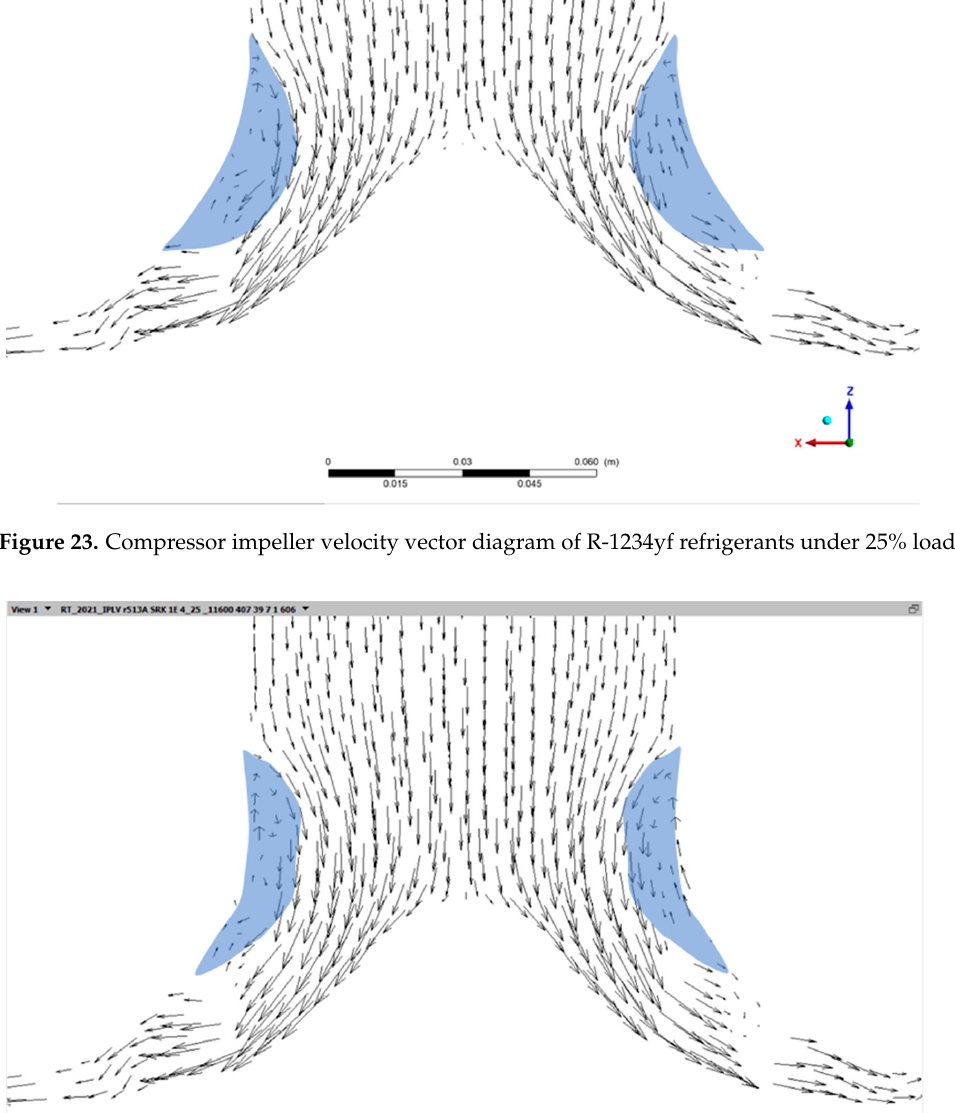
Figure 24. Compressor impeller velocity vector diagram of R-513A refrigerants under 25%